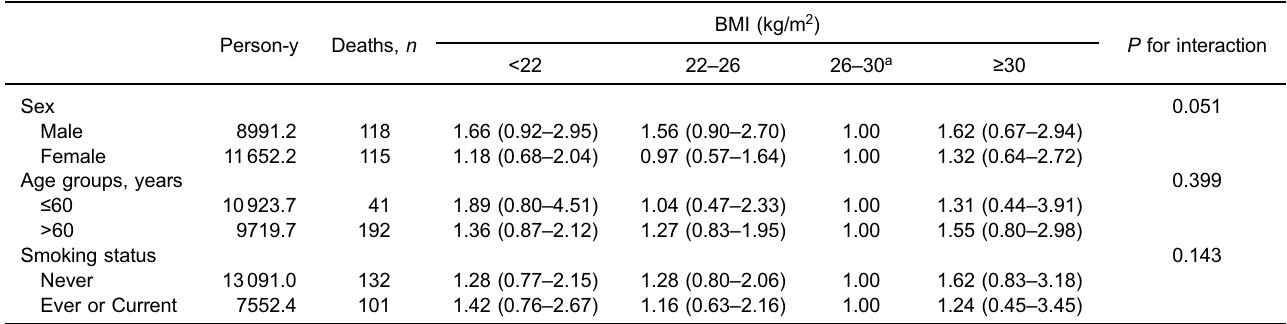
Table 5. Hazard ratio of CVD mortality according to di ff erent levels of BMI among patients with hypertension of various